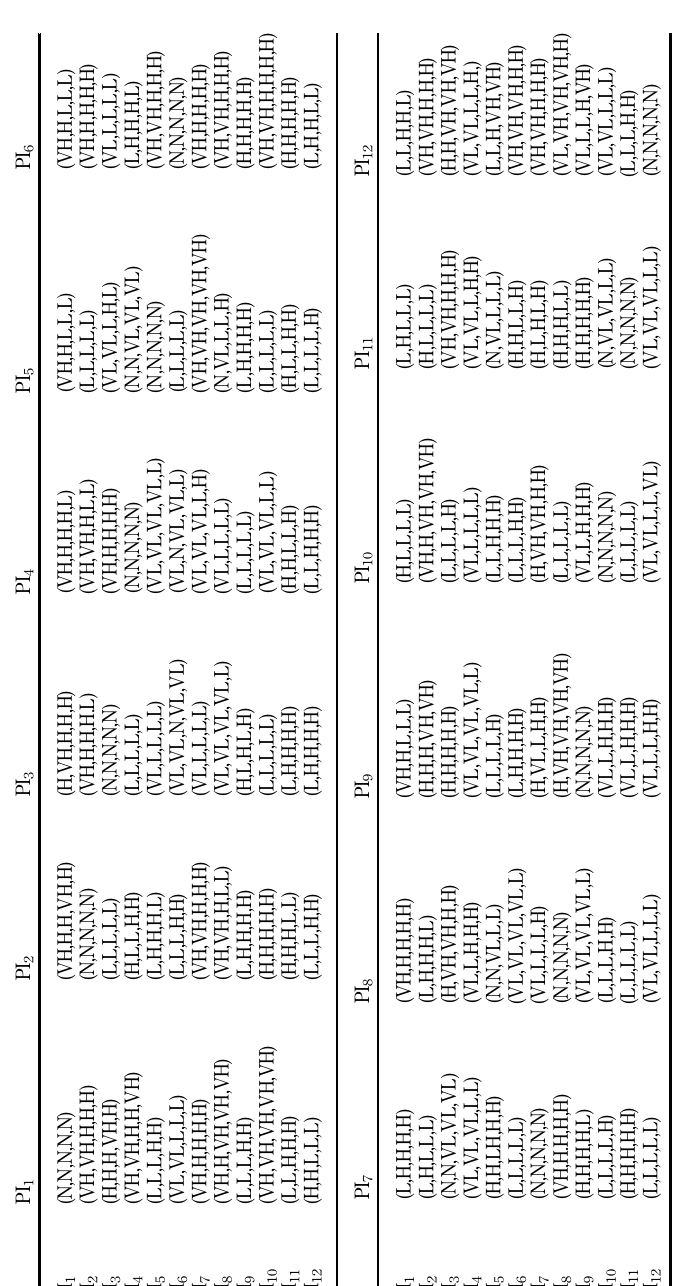
Table A5. Linguistic